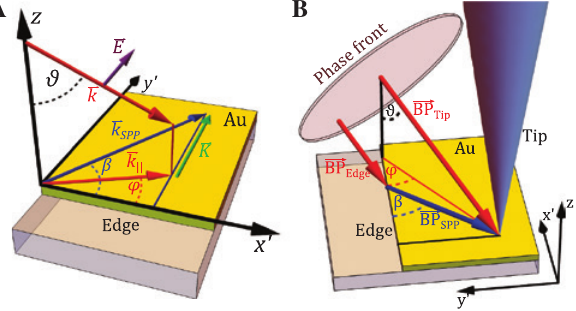
Figure 3: Schematic illustrations of the interfering signal pathways in K- and real space. (A) Schematic of wave vectors and angles for the derivation of the fringe spacings of edge-launched SPPs and (B) schematics of beam path of incident light and edge-launched